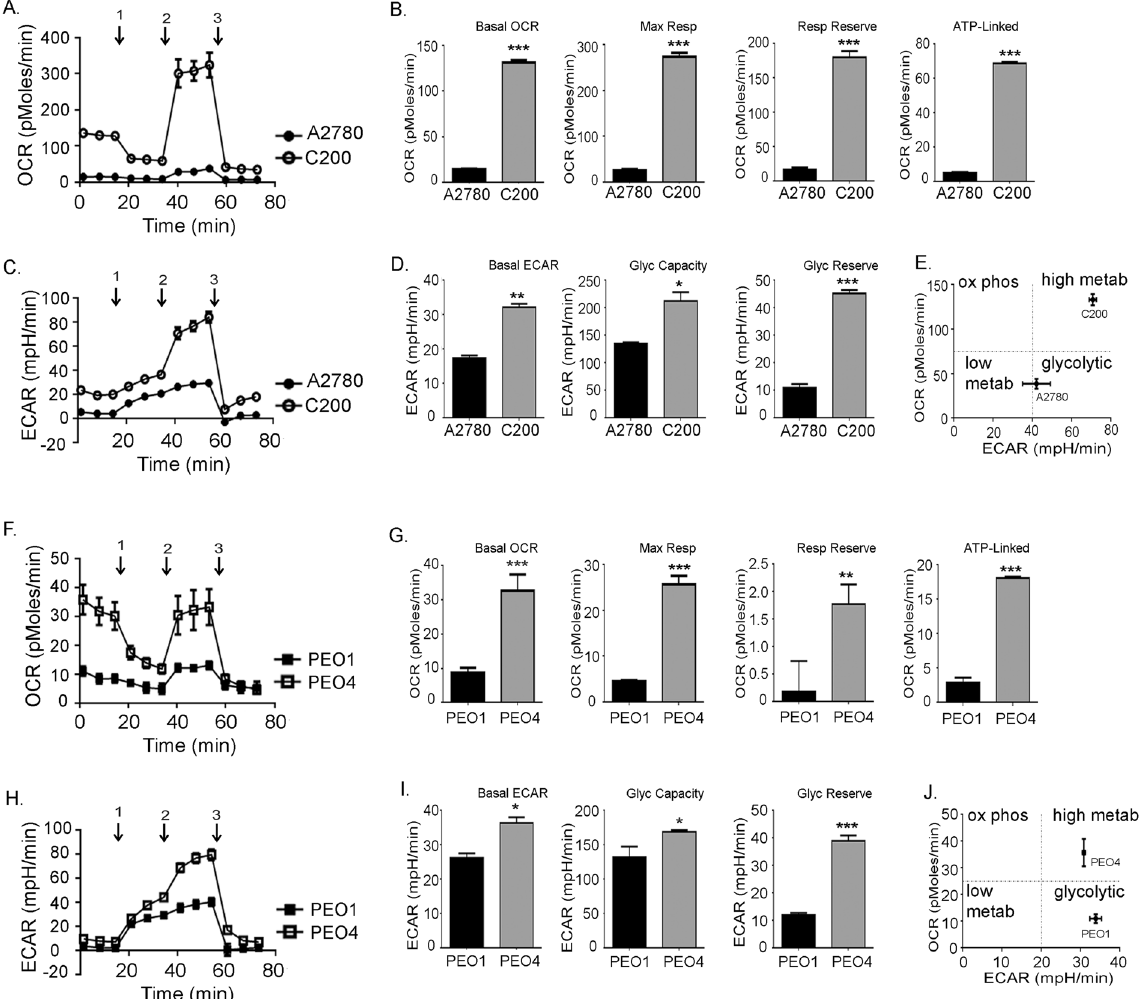
Figure 2. Bioenergetics organization of chemosensitive and chemoresistant ovarian cancer cells. ( A ) Oxygen consumption rate (OCR) was measured in chemosensitive A2780 and resistant C200 isogenic cell lines and ( F ) chemosensitive PEO1 and resistant PEO4 isogenic cell lines by a cell mitochondrial stress test when challenged by (1) oligomycin (an ATP synthase inhibitor), (2) FCCP (an electron transport chain uncoupler) and (3) rotenone (an inhibitor of electron transport chain). ( B , G ) Basal OCR represents the mitochondrial respiration at resting state, the maximum respiration indicates the cellular reaction to an increased ATP demand using FCCP mitochondrial uncoupler, and respiratory reserve and ATP-linked respiration indicate greater capacity to utilize mitochondria. These were calculated as described in the Materials and Methods. *** p < 0.001, ** p < 0.01 chemoresistant cells (C200 and PEO4 compared to respective chemosensitive cells [A2780 and PEO1]). Extracellular acidification rate (ECAR) was measured in ( C ) chemosensitive A2780 and chemoresistant C200 isogenic cell lines and ( H ) chemosensitive PEO1 and resistant PEO4 isogenic cell lines when challenged by (1) glucose (fuel for glycolysis), (2) oligomycin (an ATP synthase blocker) and (3) 2DG (an inhibitor of glycolysis). ( D , I ) Basal ECAR represents the glycolysis measure at resting state, glycolytic capacity represents the total ability of the cell to perform glycolysis (resting state and enforced combined) and glycolytic reserve defines the capacity to increase glycolysis when mitochondria is compromised, were calculated as described in the methods. *** p < 0.001, ** p < 0.01, * p < 0.05 chemoresistant cells (C200 and PEO4 compared to respective chemosensitive cells [A2780 and PEO1]). ( E , J ) Ratio of OCR: ECAR quadrant showing the bioenergetics phenotype of each cell line. All Seahorse experiments (Seahorse Biosciences, Boston, MA) were performed for a minimum of 5 times in triplicates. Abbreviations: ATP: adenosine triphosphatase; 2DG: 2-deoxyglucose; FCCP: carbonylcyanide-p-trifluoromethoxyphenyl